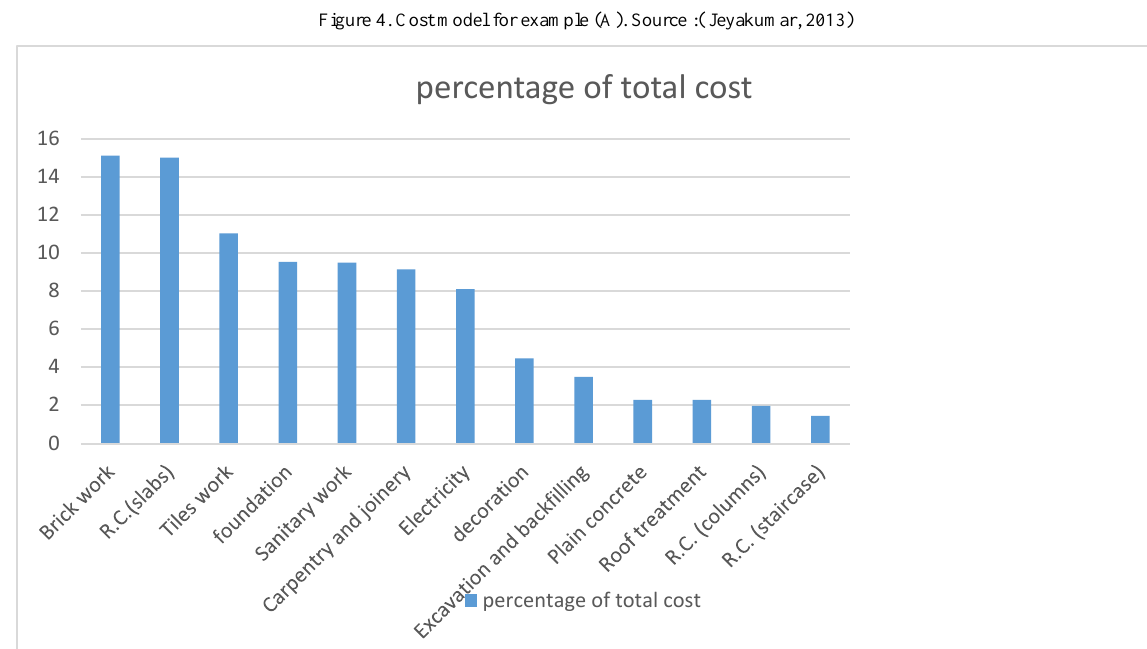
Figure 4. Cost model for example (A). Source :( Jeyakumar, 2013)